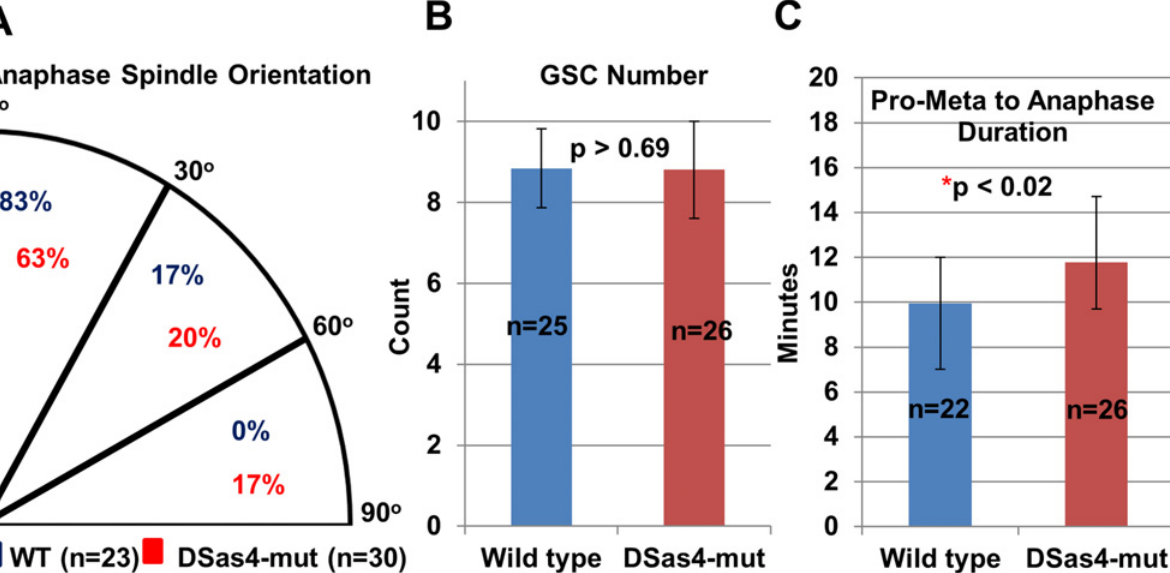
Fig 1. Most spindle orientation at anaphase and stem cell number are maintained in GSCs without centrosomes. (A) Live imaging reveals that most DSas4-mut GSCs maintain their spindle orientation compared to the wild type. (B) There is no significant difference of GSC number per testes in DSas4-mut and wild type flies. (C) The mitosis duration from pro-metaphase to anaphase in DSas4-mut GSCs is significantly longer than that in wild